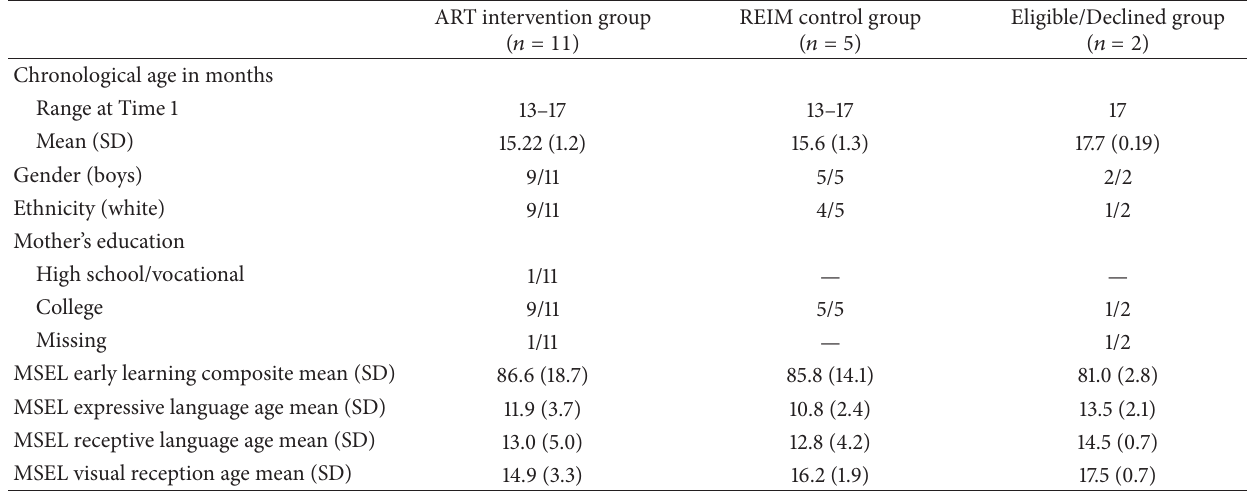
Table 1: Participant demographics of RCT eligible families ( 𝑛 = 18